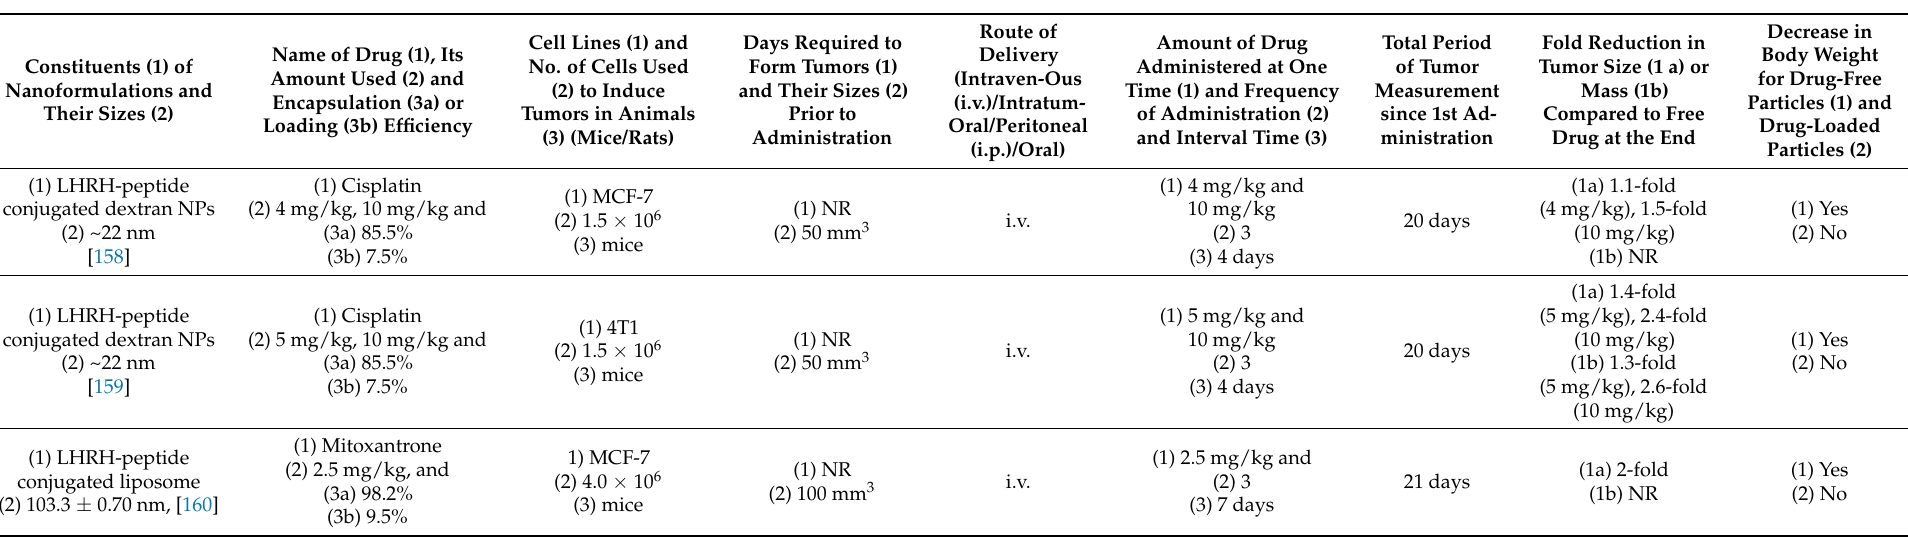
Constituents (1) of Nanoformulations